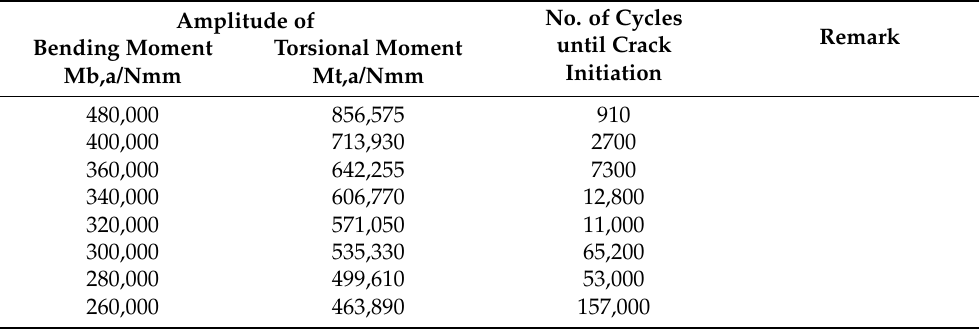
Table A4. Test results for nonproportional combination of bending and torsion ( τ xy,a / σ x,a = 0.75), phase shift between torsion and bending ∆ ϕ = 90 ◦